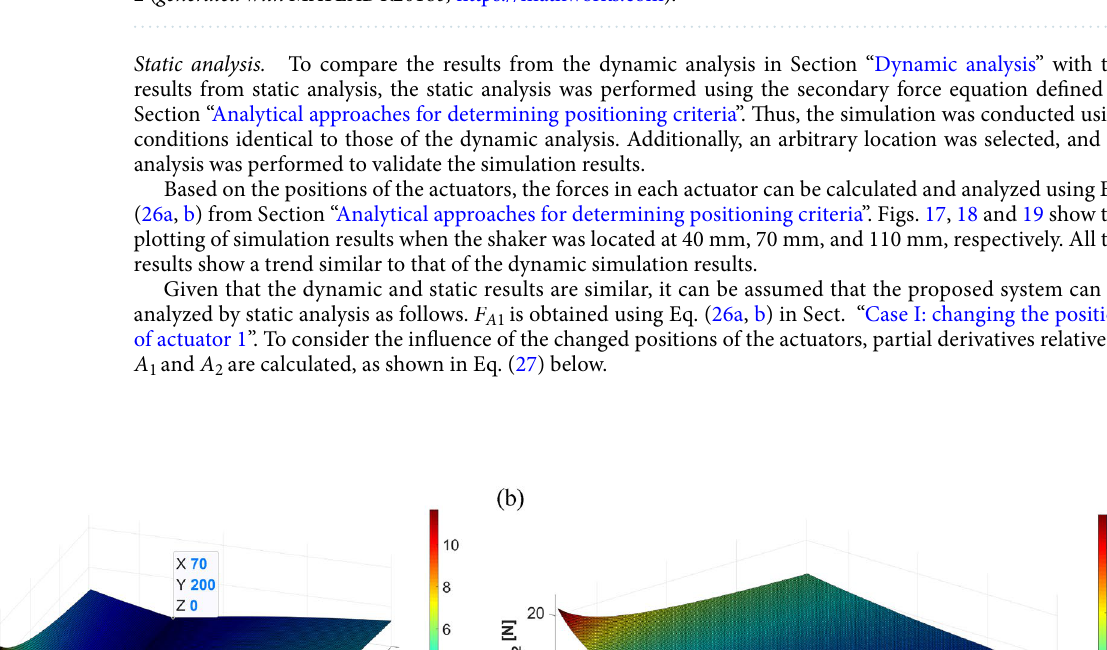
Figure 17. Control force of actuators 1 and 2 from static analysis (shaker at 40 mm): ( a ) actuator 1; ( b ) actuator 2 ( generated with MATLAB R2018b, https:// mathw orks. com).